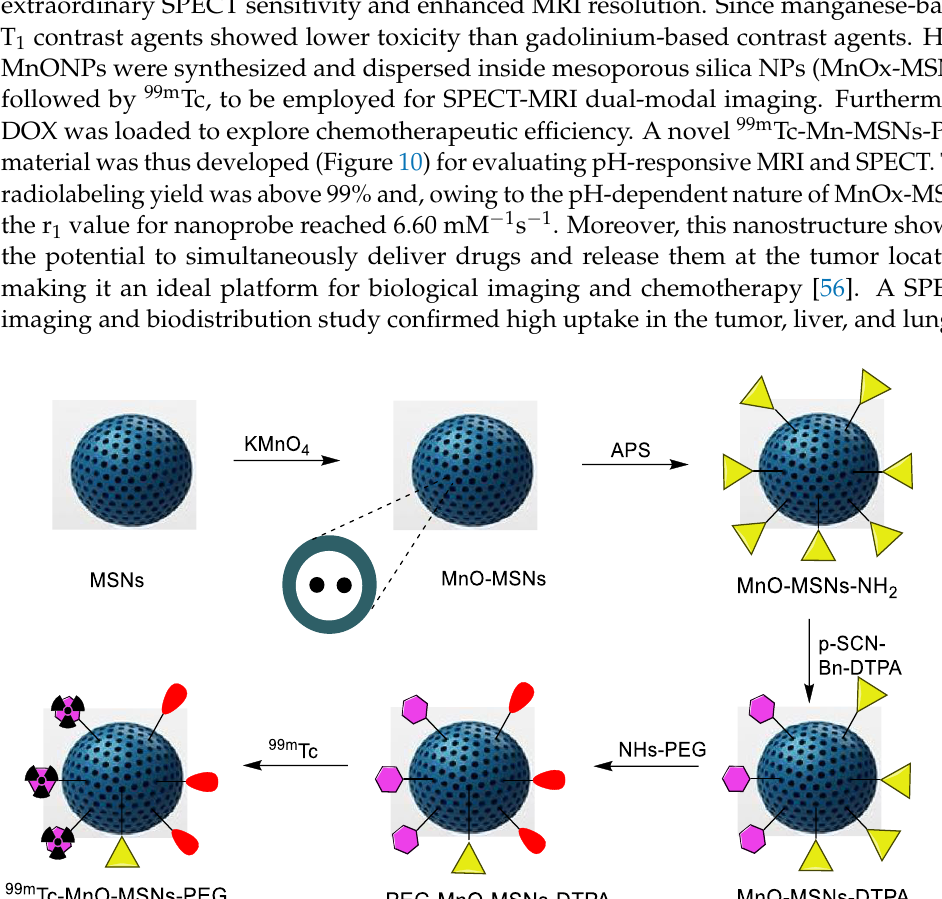
Figure 10. Schematic diagram for the synthesis of the 99m Tc-MnO-MSNs-PEG nanodrug [56].